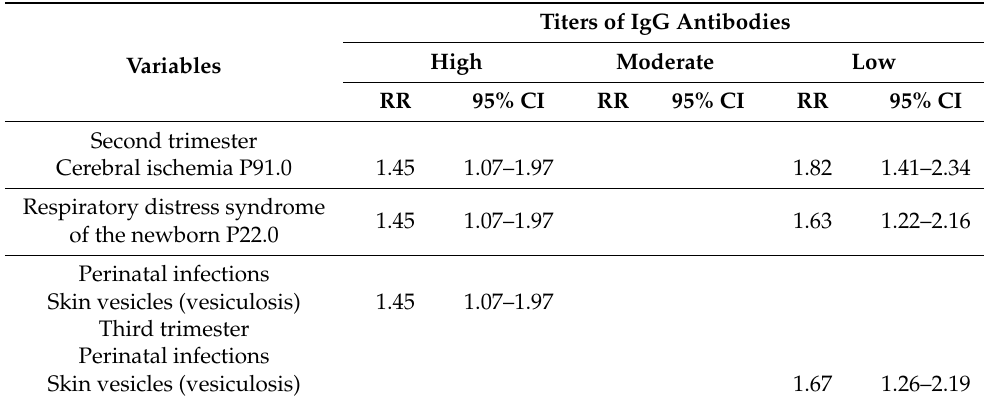
Table 12. Risk factors for the development of complications of the early antenatal period, depending on the titers of IgG antibodies in women with recurrent HSV-1 during pregnancy. Titers of IgG Antibodies High Moderate Low Variables RR 95% CI RR 95% CI RR 95% CI Second trimester Cerebral ischemia P91.0 1.45 1.07–1.97 1.82 1.41–2.34 Respiratory distress syndrome 1.45 of the newborn P22.0 Perinatal